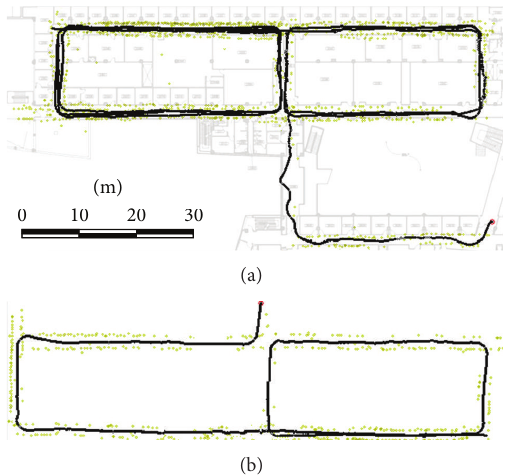
Figure 13: (a) Experimental results of the proposed ranging and SLAM algorithm with state observer odometer trail. Actual floor- plan of the building is superimposed later on a mature map to illustrate the accuracy of our method. Note that the floor plan was not provided to the system a priori. (b) The same environment mappedbyagroundrobotwithadifferentstartingpoint,toillustrate that our algorithm is compatible with different platforms.